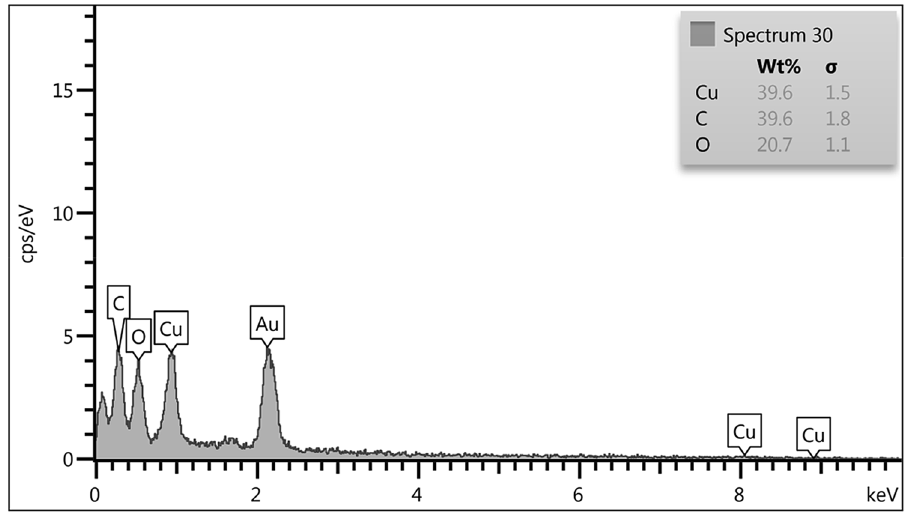
Figure 6. EDX analysis of biogenic CuO